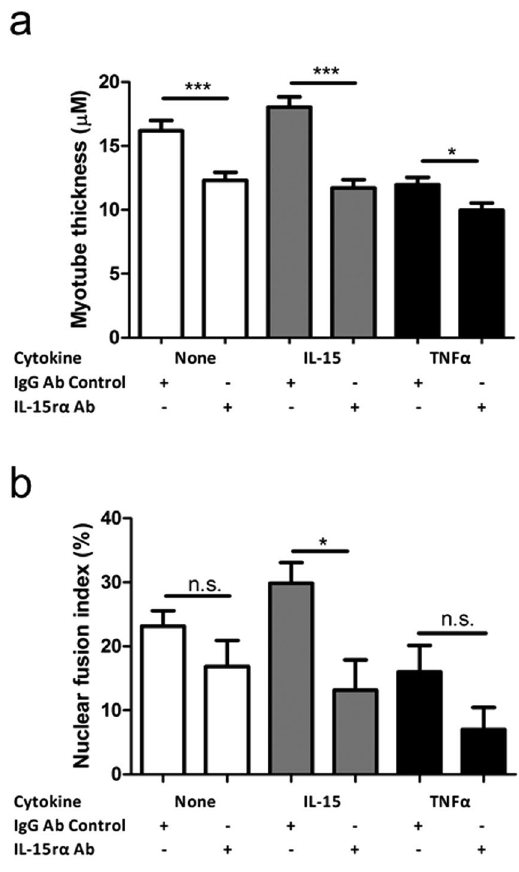
Figure 6. Antibody neutralisation of IL-15r α eliminates the myogenic effects of IL-15 and enhances the detrimental effects of TNF α on myotube development. Subconfluent myoblasts were switched to differentiation medium containing the indicated recombinant cytokines and antibodies (IL-15, 25 ng/mL; TNF α , 1 ng/mL; IL-15r α antibody, 1 µ g/mL; IgG1 antibody, 1 µ g/mL) for 8 d. Media were renewed every 2 d. Myotubes were fixed, immunofluorescence stained for desmin and DAPI and imaged on an epifluorescence microscope. ( a ) Myotube thickness data represents the mean ± SEM of 450 total measurements taken at 63x magnification from 90 myotubes per treatment condition (from 3 biological replicates). ( b ) Nuclear fusion index data represents the mean ± SEM values from 45 images taken at 20x magnification (from 3 biological replicates). * p < 0.05, *** p < 0.001 vs. IgG control condition by